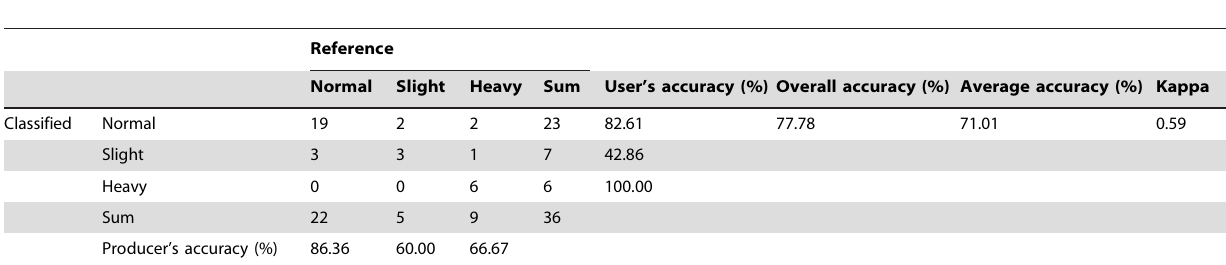
Table 6. Confusion matrix and classification accuracies created by the integrated approach of MTMF and